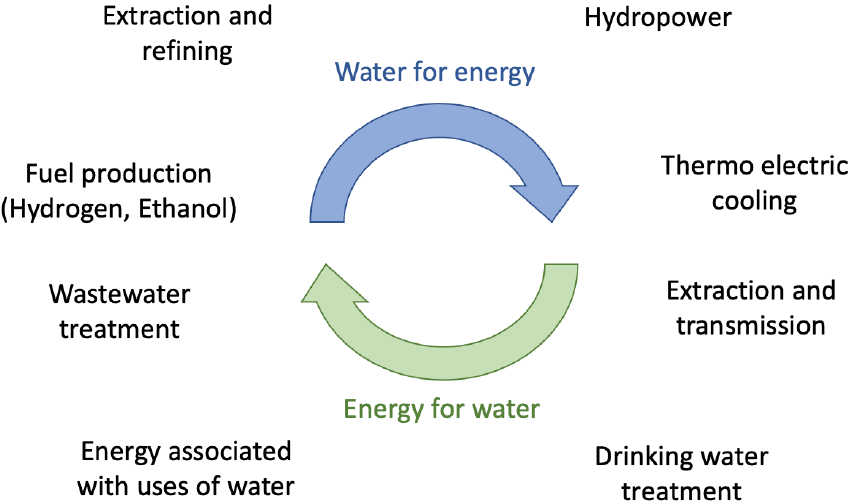
Figure 1. Water and energy consumption cycle.